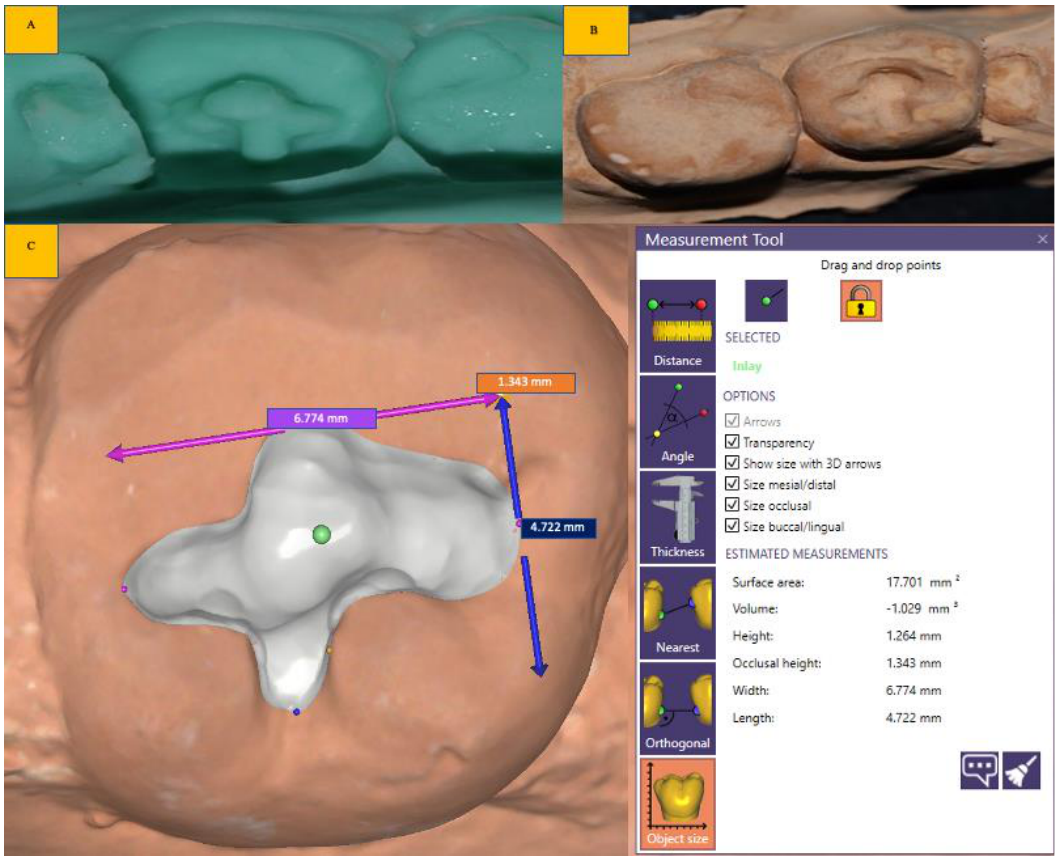
Figure 2. The steps of volume determination by 3D scanner: ( A ): silicon impression; ( B ): working cast; ( C ): volume determination illustration (mm 2 ) using exocad software.